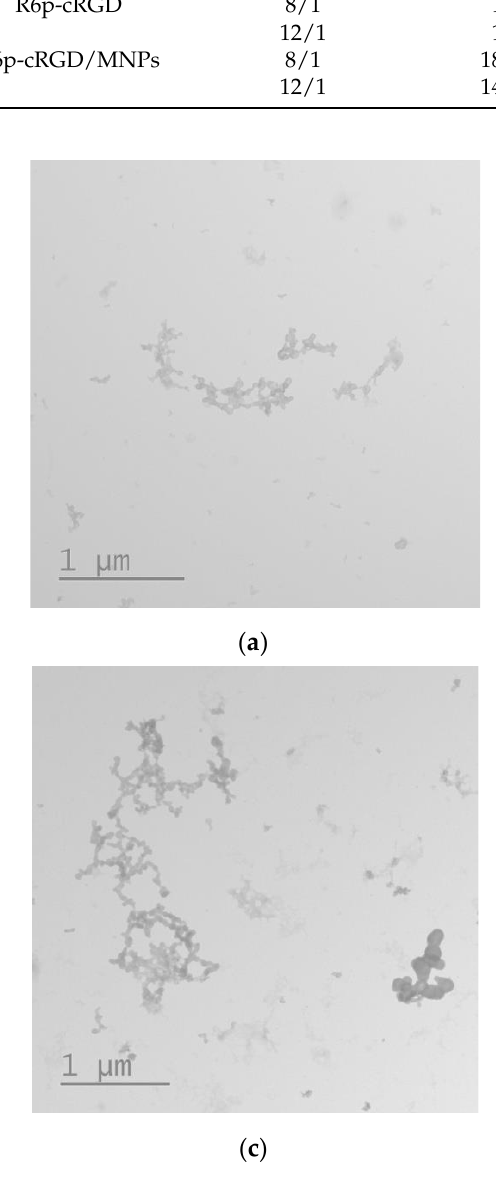
Figure 4. Typical micrographs of the R6p-cRGD/DNA/MNPs polyplexes obtained by transmission electron microscopy: ( a , b ) N/P ratio of R6p-cRGD/DNA is of 8/1; ( c , d ) N/P ratio is of 12/1.